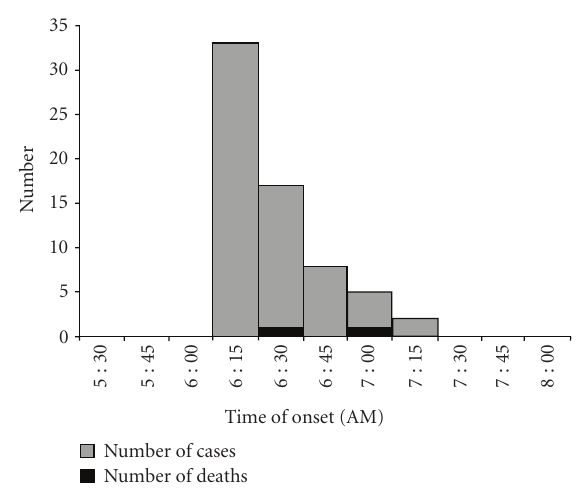
Figure 1: Cases of organophosphorous poisoning by time of onset at Sindhikela, Bolangir, Orissa, India, 2 February